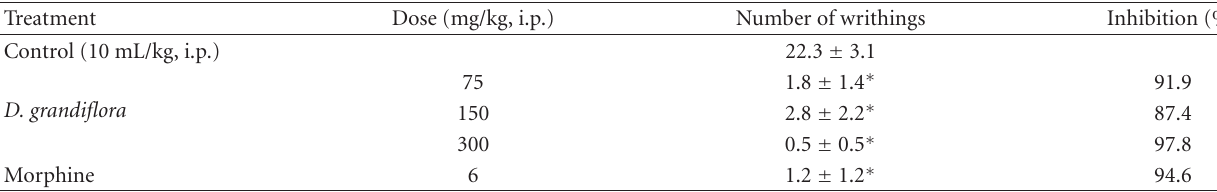
Table 1: E ff ect of EDgP on acetic acid-induced writhings in mice. Treatment Dose (mg/kg, i.p.) Control (10 mL/kg, i.p.)